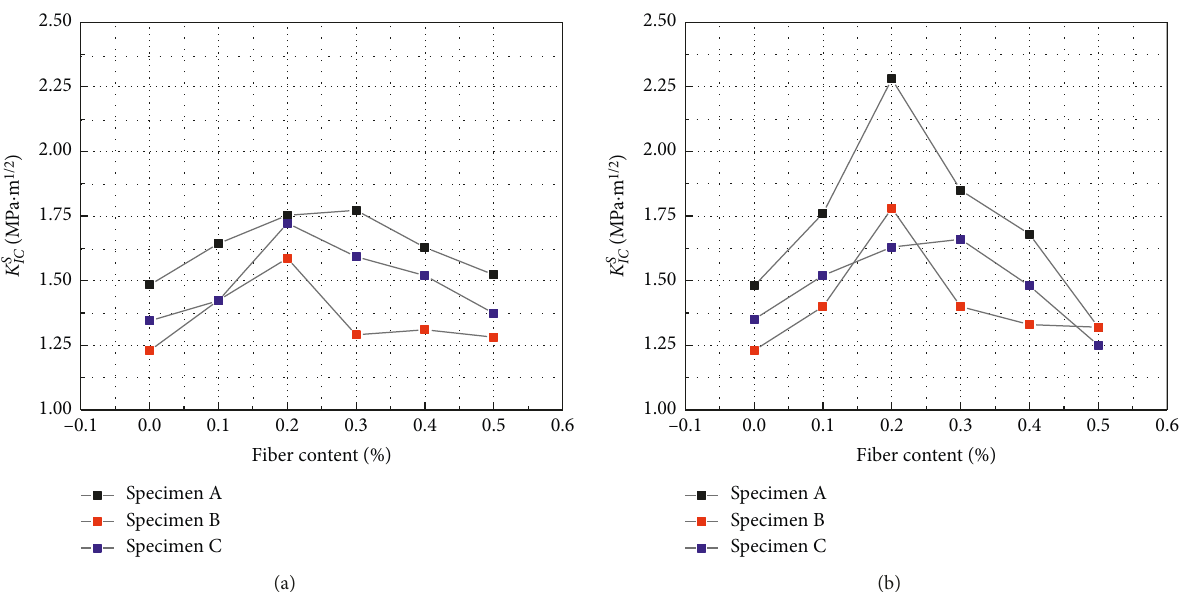
Figure 5: Unstable fracture toughness vs. basalt fiber dosage. (a) The fiber length is 6mm. (b) The fiber length is 12 mm.